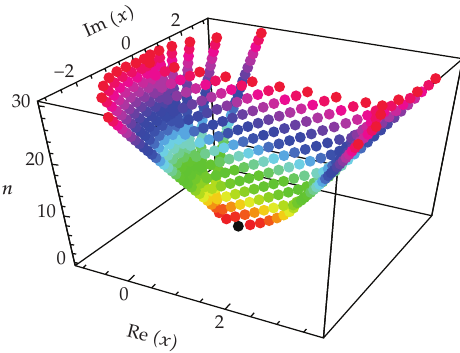
(cid:2) h (cid:3) (cid:2) x (cid:3) , 1 ≤ n ≤ 30. n,q